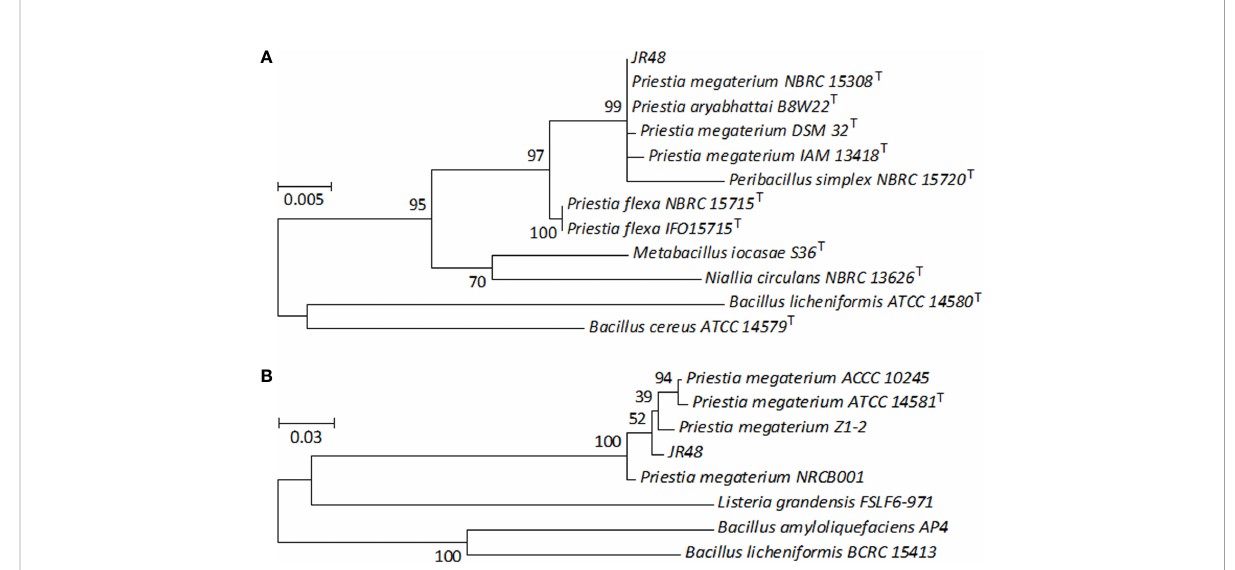
FIGURE 2 Phylogenetic analysis of JR48. (A,B) Phylogenetic tree based on the partial 16S rRNA gene (A) and gyrB gene (B) sequences of JR48. Phylogenetic tree was constructed by MEGA 7.0 software using the maximum likelihood method with 100 bootstrap replicates. The percentage numbers at the nodes indicate the levels of the associated taxa clustered together. The tree is drawn to scale, with branch lengths were proportional to the number of nucleotide substitutions per site. The scale bar indicates 0.005 (A) and 0.03 (B) nucleotide substitutions per site. T , type